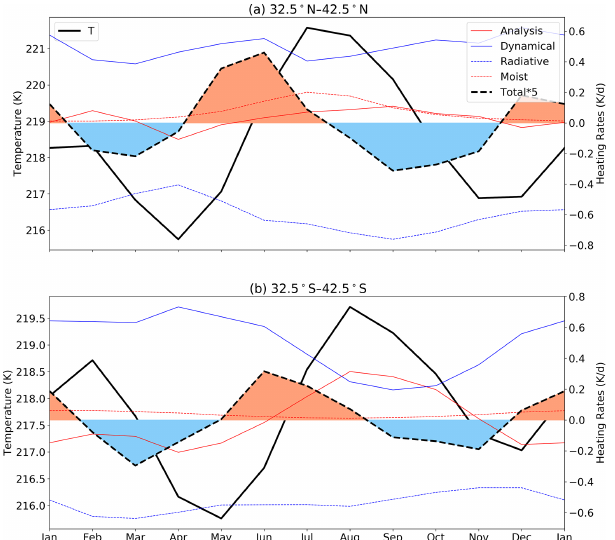
Figure 4. Annual cycle of the zonal mean temperature ( T ) and heat- ing rates at 200hPa averaged around the NHM 32.5–42.5 ◦ N (a) and the SHM 32.5–42.5 ◦ S (b) based on MERRA2 data. The red, blue, dashed blue and dashed red lines indicate the heating rates related to analysis tendency dynamics, radiation and condensation, respec- tively. The positive total heating rates are filled with light red color and the negative total heating rates are filled with light blue color. The total heating rates, which are the sum of analysis, dynamical, radiative and moist heating rates, have been enlarged 5 times to be more visible in the figures.